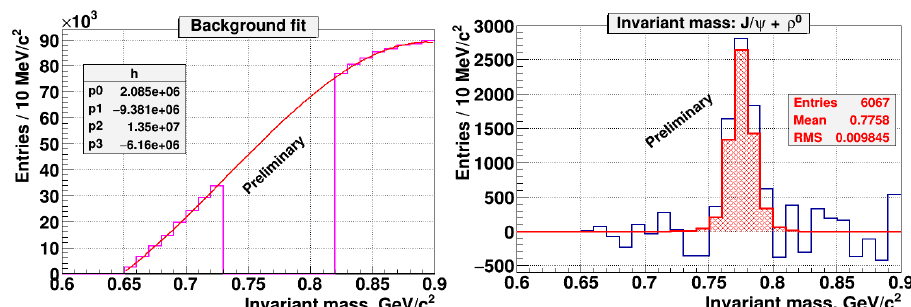
Figure 7. Left - Background estimation using the polynomial fit of the side bands of Fig. 6 (left). Right - background - subtracted invariant mass combination from Fig. 6 (left) (blue line) and true X(3872) histogram (red